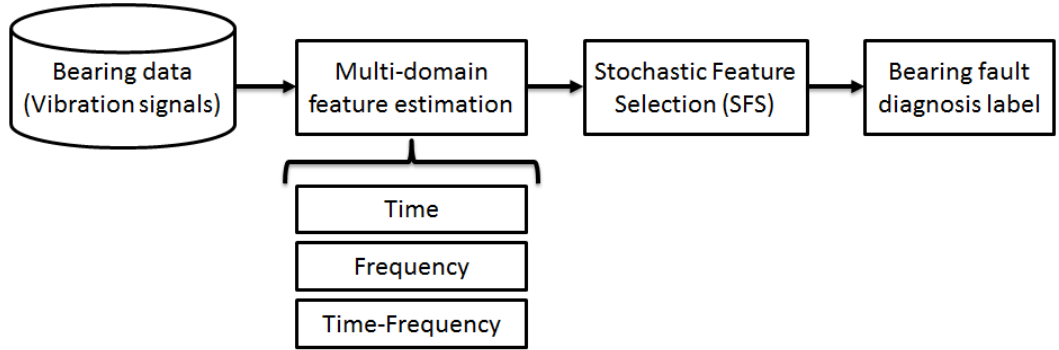
Figure 1. Sketch of the proposed bearing fault diagnosis from vibration signals. Time, frequency, and time-frequency features are computed under a windowing scheme from vibration signals. Then, our Stochastic Feature Selection (SFS) applies a relief-F-based ranking, and a Hidden Markov Model to highlight relevant features and predict the signal label (bearing health